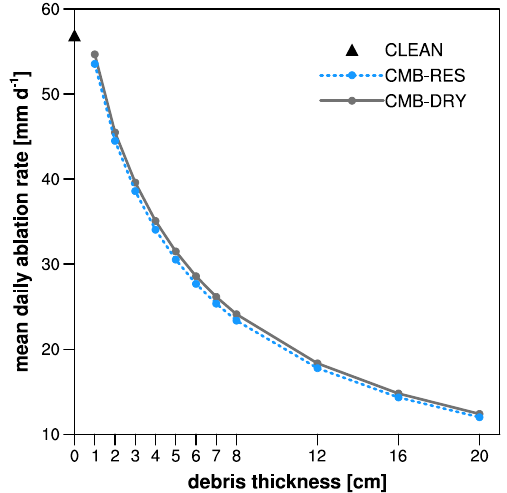
Fig.12. Dailymeansub-debrisiceablationrate[ mmw . e . d − 1 ]vs. Figure 12. Daily mean subdebris ice ablation rate (mmw . e . d − 1 ) debristhickness[ cm ],producedbytheCMBmodelsusingtheforc- ingdatafromthe2008simulation.Thecleanicemeltrateisrepre- vs. debris thickness (cm), produced by the CMB models using the sented by a black triangle. CMB-DRY is the solid-grey curve and forcing data from the 2008 simulation. The clean-ice-melt rate is CMB-RESisthedashed-bluecurve. represented by a black triangle. CMB-DRY is the solid-grey curve and CMB-RES is the dashed-blue